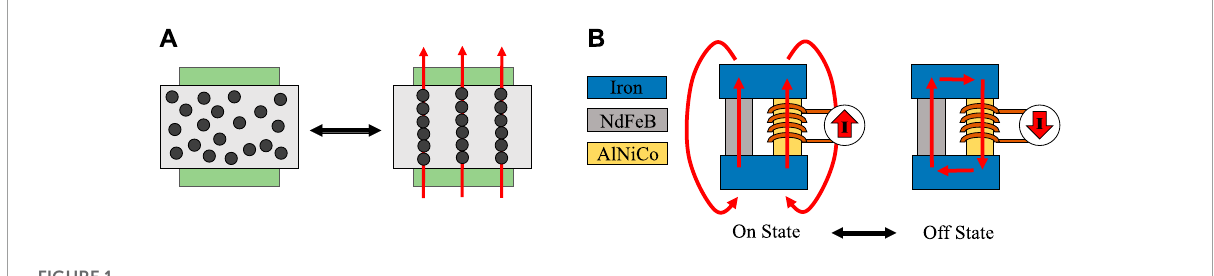
FIGURE 1 (A) The principle of MRF, where an applied magnetic field causes the ferromagnetic particles in suspension to align and form polymer-like chains, affecting the fluid’s shear behavior. (B) The principle of an EPM, where two states can be toggled by the direction of the magnetization of the AlNiCo magnet.